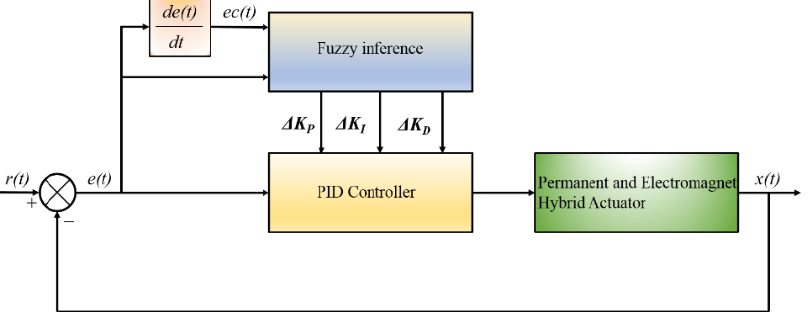
Figure 10. The block diagram of fuzzy PID controller.